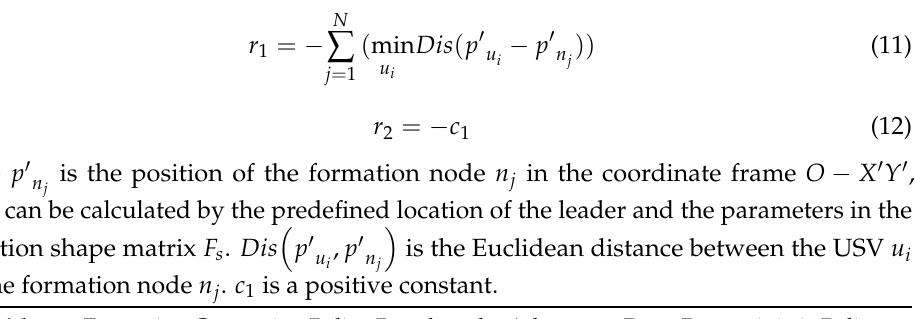
Algorithm 1: Formation Generation Policy Based on the Advantage Deep Deterministic Policy Gradient